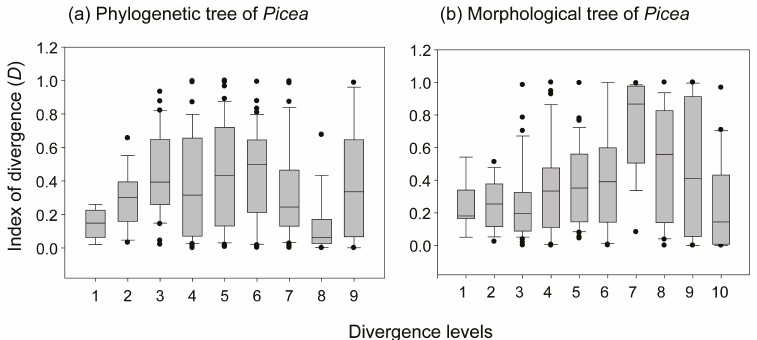
Figure 4. Box plots showing the index of divergence at each of the splitting levels in the phylogenetic tree (a) and the morphological tree (b) of spruce species worldwide. The central box in each box plot indicates the interquartile range and median, whereas the whiskers show the 10th and 90th percentiles. Mean values marked with different letters indicate a significant difference at P < 0 .